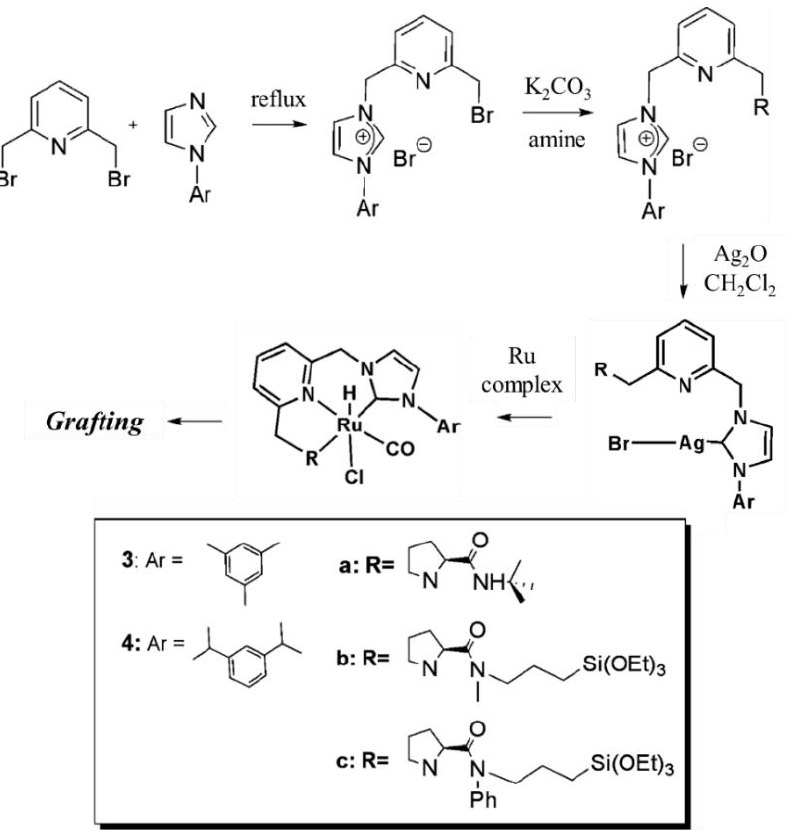
Figure 21. Schematic representation of the synthesis of silica-supported chiral Ru complexes [113]. Reprinted with permission from [113]. Copyright 2011, Royal Society of Chemistry.